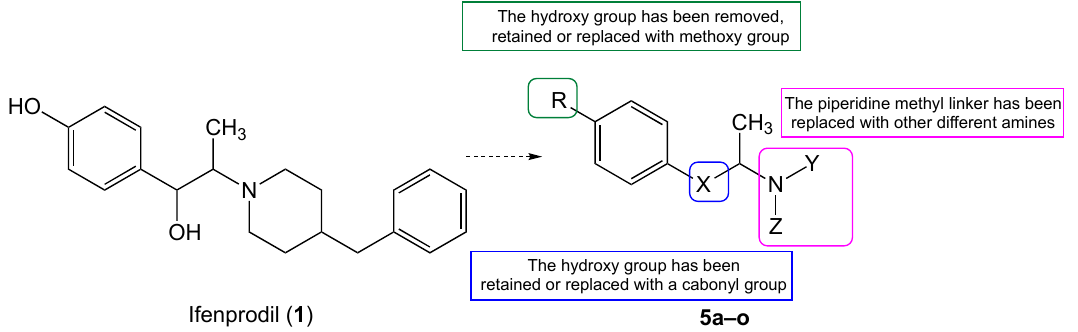
Figure 1. Rationale of the new ifenprodil analogues 5a–o .